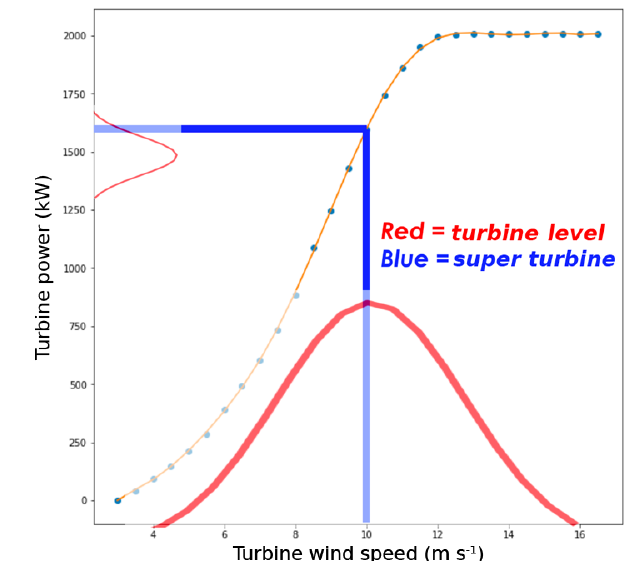
Figure 1. Illustration of an instance of converting wind speed to power for a number of turbines and for the average wind speed across the turbines, which is termed the super-turbine power con- version methodology. This shows that the mean power converted from the distribution of wind speeds at the turbines is less than the super-turbine power conversion for a mean wind speed of 10ms − 1